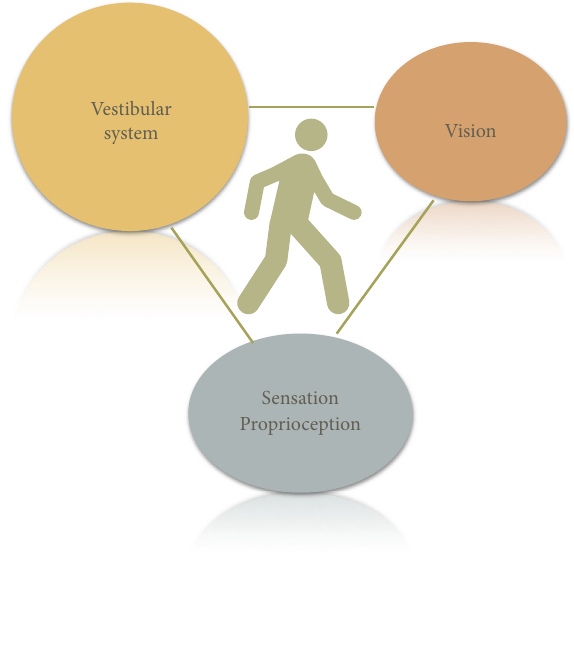
Figure 1: The Balance System. Balance as a function of vestibular system with visual and sensory